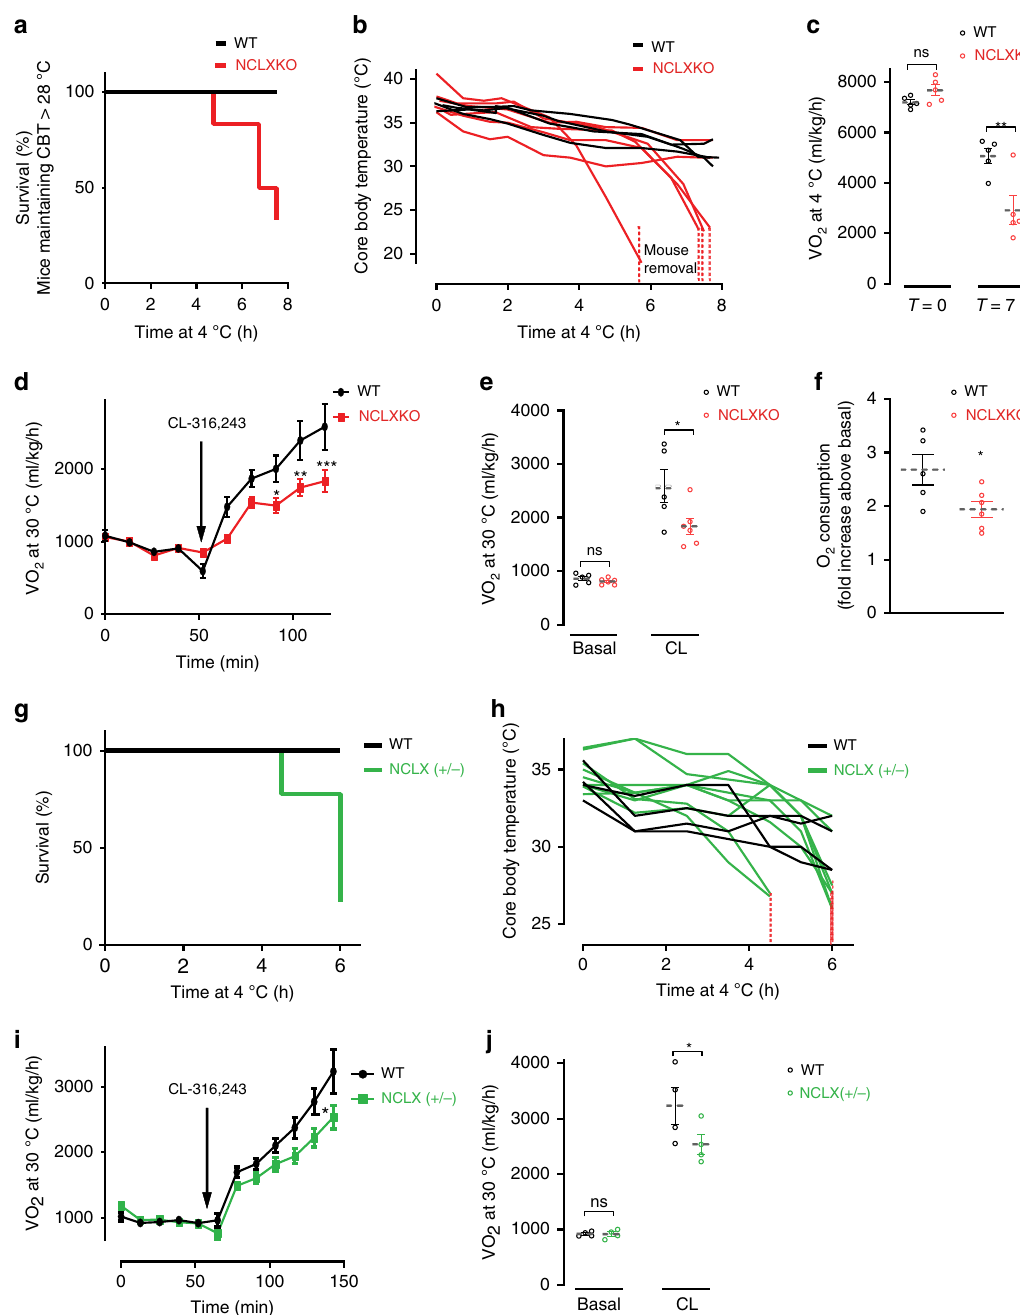
Fig. 3 Thermogenesis is impaired in NCLX-null mice. a Survival curves of 8 – 10-week-old NCLX KO and WT male mice cold stressed at 4 °C. Animals reaching temperatures 28 °C and below were returned to room temperature for recovery and counted as drop-outs. Survival rates depict the rate at which animals had to be removed from 4 ° C to room temperature to avoid mortality ( n = 4 mice for WT and n = 6 mice for NCLX KO). CBT, core body temperature. b Core body temperature traces of the animals from experiment ( a ) during cold exposure (4 °C). The dashed red line indicates animal removal. c VO 2 of NCLX KO and WT mice subjected to cold (4 ° C) at t = 0 and t = 7 h ( n = 5 mice per group). d – f Non ‐ shivering thermogenesis of NCLX KO and WT mice assessed by measuring O 2 consumption at baseline and followed by β -3 adrenergic stimulation (CL-316,243 injection (1 mg/kg)) in anesthetized mice at 30 °C. d Traces of VO 2 of NCLX KO and WT mice. e VO 2 at baseline and under CL stimulation. f Fold increase of O 2 consumption after the CL stimulation ( n = 5 mice for WT and n = 6 mice for NCLX KO). g Survival curves of WT and NCLX heterozygous ( + / − ) littermates cold stressed at 4 °C; mice reaching 28 °C or lower were returned to room temperature for recovery and counted as drop-outs ( n = 4 mice for WT and n = 9 mice for NCLX + / − ). h Core body temperature of the animals shown in g . i VO 2 of WT and NCLX + / − mice at basal and after CL-316,243 injection (1 mg/kg), under anesthesia at 30 °C. Traces of VO 2 of NCLX + / − and WT mice. j VO 2 at baseline and under CL stimulation ( n = 4 mice per group). Student ’ s t -test ( c , e , f , j ); two-way ANOVA ( d , i ). Data are expressed as means ± SEM. ns p > 0.05, * p < 0.05, ** p < 0.001, *** p < 0.0001. Replicates are indicated by individual dots shown for each group in all graphs. Source data are available as a Source Data fi